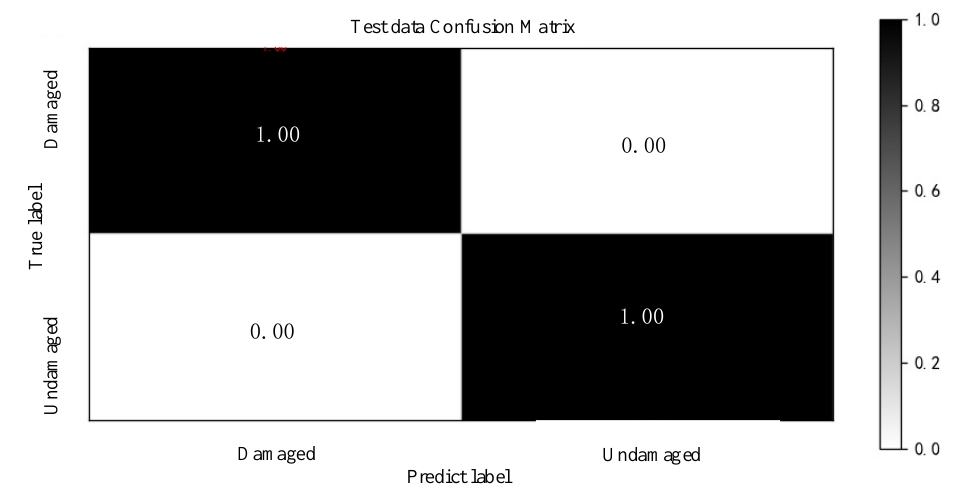
Figure 8. Confusion matrix.